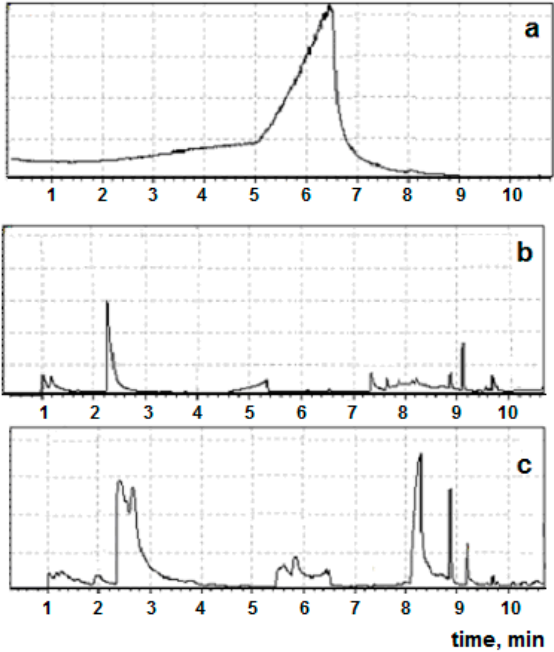
Figure 12. Chromatograms of original phenol ( a ), intermediate products of phenol decompo- sition at UV-irradiation ( b ) or visible light irradiation ( c ) to solutions in presence of composite [( ≡ TiO) n ]:[HEMA]:[AN] + Ag